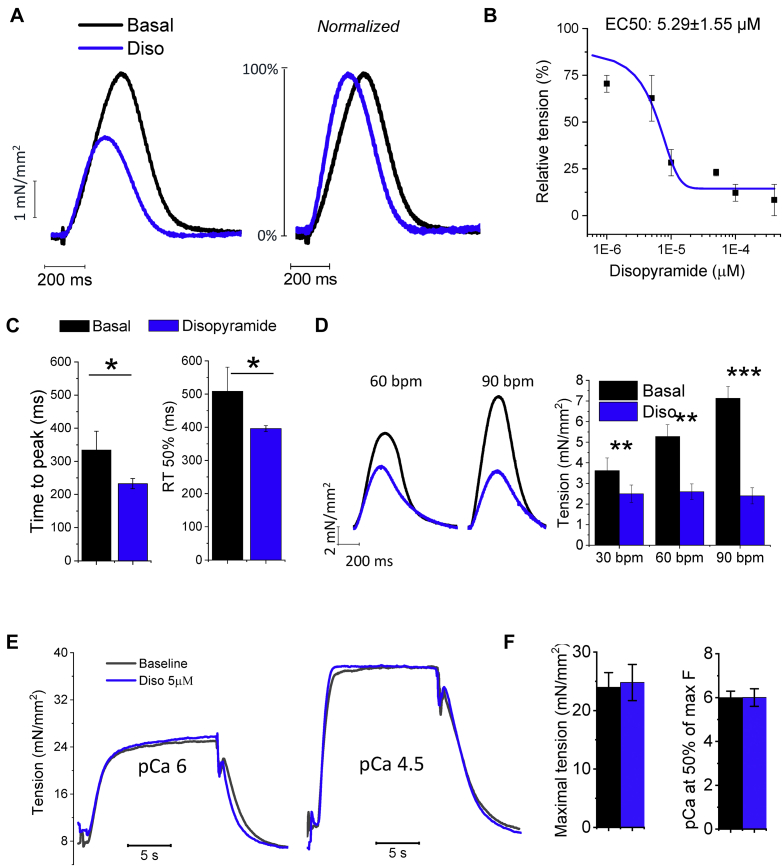
Effects of Disopyramide in Myocardial Mechanics in Intact and Skinned Trabecuale(A) Representative superimposed force twitches elicited at 0.5 Hz in hypertrophic cardiomyopathy (HCM) trabeculae in the absence (black trace) and presence (blue trace) of disopyramide 5 μmol/l (Diso). (B) Relationship between the negative inotropic effect of disopyramide and its concentration in the extracellular fluid; calculated concentration at which 50% of the maximal effect is obtained (EC50) is shown. Mean ± SEM from 5 trabeculae, 5 patients. (C) Time from stimulus to peak and time from peak to 50% relaxation (RT50%) of force twitches elicited at 1 Hz at baseline (black) and in the presence of disopyramide (blue). (D) Effects of disopyramide at different stimulation frequencies. Disopyramide slightly reduces the slope of force-frequency relationship at higher pacing rates. (C,D) Mean ± SEM from 13 trabeculae, 10 patients (ID# 1, 2, and 5 to 12). (E) Disopyramide in skinned trabeculae from patients with HCM. As shown in these superimposed traces from an HCM trabecula, disopyramide does not reduce isometric force at intermediate Ca activation level (pCa 6) or at maximal myofilament activation (pCa 4.5). (F) Maximal tension and pCa at one-half of maximal tension (Ca sensitivity) in HCM trabeculae, in the absence and presence of disopyramide. Means ± SEM from 6 trabeculae, 3 patients (ID# 12, 15, and 16). (C,D,F) *0.05 > p > 0.01; **0.01 > p > 0.001; ***p < 0.001; linear-mixed models. bpm = beats/min.